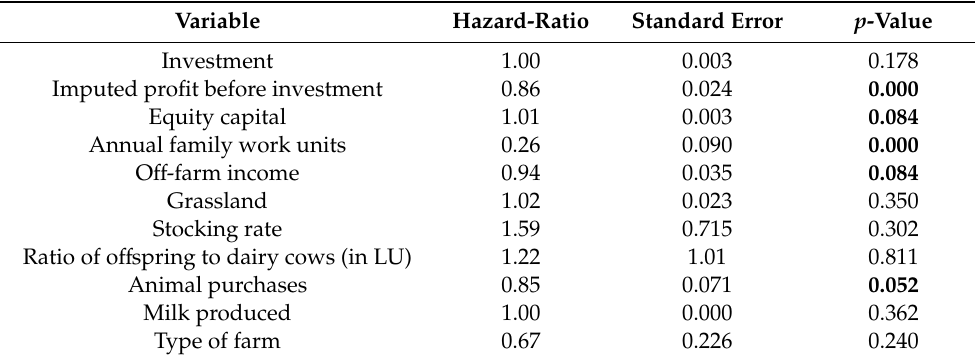
Table 2. Results of the Cox proportional-hazards